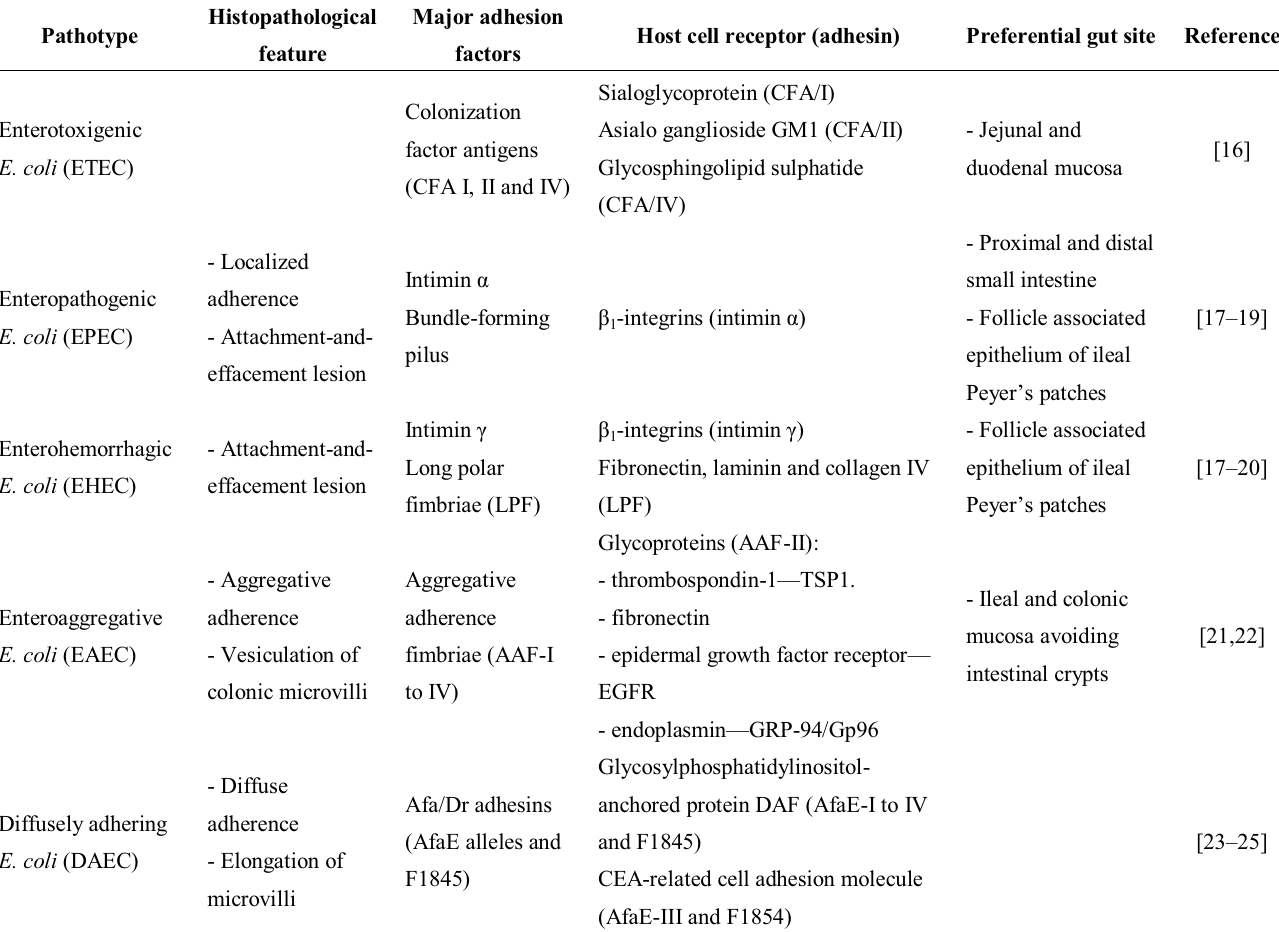
Table 1. Traits of the diarrheagenic pathotypes of enteroadherent Escherichia coli